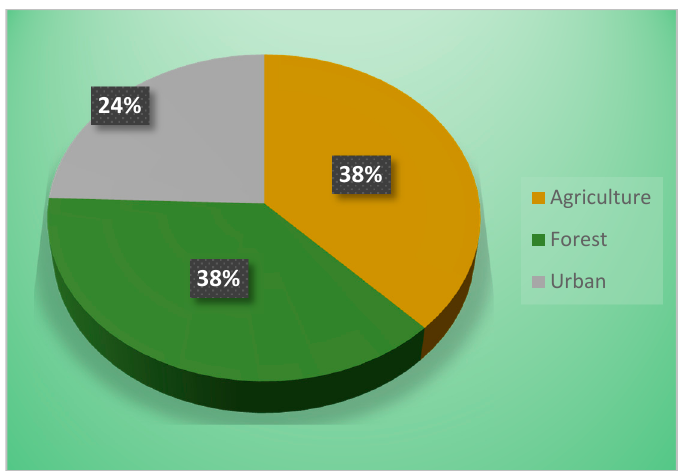
Figure 10. Loch Raven watershed land use distribution.